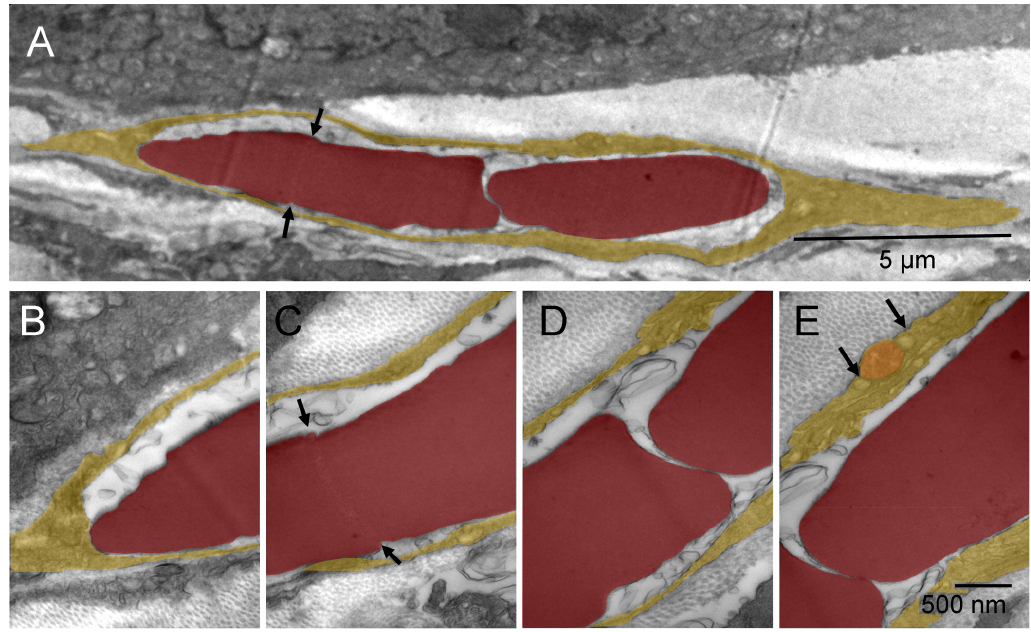
Figure S3. Erythrogenic autophagy in elongated cell between tumor nodules; resemblance to the vasculogenic mimicry. Consecutive splitting of an erythroschizont into erythrosomes (red); one completely separated and the rest in the process of splitting, all surrounded by leftover cytoplasm of the cell producing them (yellow) [ A ]. Four enlarged regions of that cell [ B – E ]. A distinct region of the erythroschizont indicated location of the next, already initiated, split (arrows) [ A & C ]. Vesicles on both sides of the mitochondrion (orange) contained collagen fibers (arrows) [ E